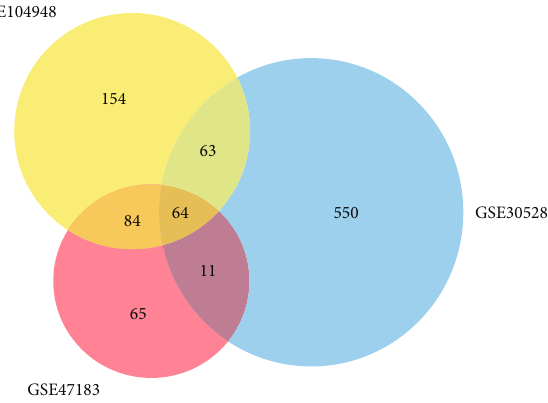
Figure 2: Overlapping DEGs of multiple